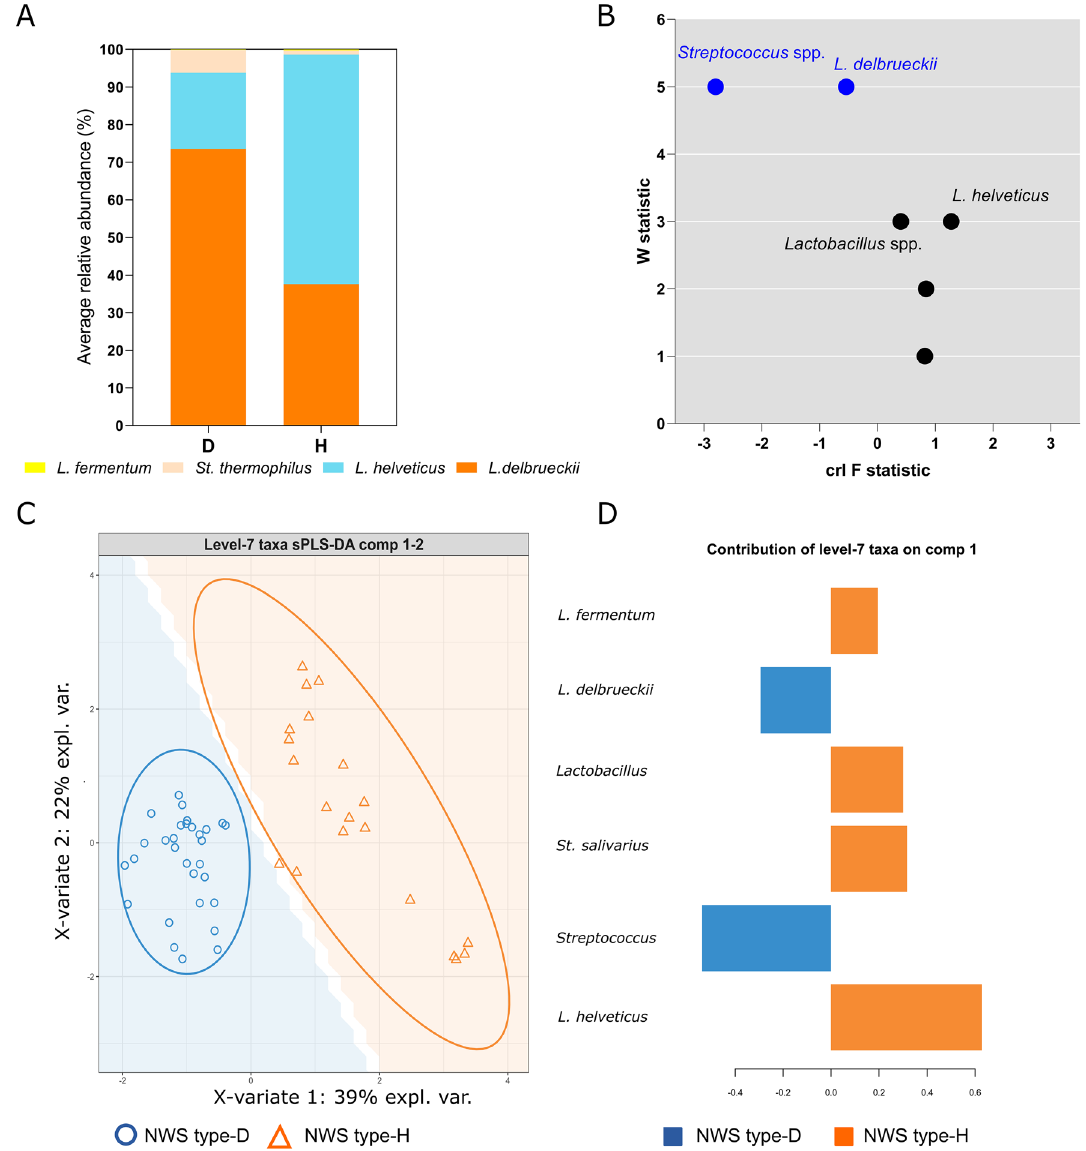
Figure 5. ( A ) Species level composition of NWS type-D and type-H. The average relative abundances of each bacterial taxon and clusters are reported on the vertical and horizontal axis, respectively. ( B ) ANCOM differential abundance volcano plot. ( C ) sPLS-DA of the NWS samples ( n = 50) showing discrimination between samples H (blue circles) and D (orange triangles). ( D ) Loading plot shows the discriminant power of species in explaining differences between groups on component PLS1. The direction of the bars (left or right) relates to the direction of the loadings in panel A. The higher the absolute value, the bigger is the discriminative power. Orange and blue bars indicate a higher abundance in D or H group, respectively. ( A ) was plotted with GraphPad Prism v.8.00 software (San Diego, CA, USA, https:// www. graph pad. com/), while ( B – D ) were built using mixOmics R package v.6.16.0 (https:// CRAN.R- proje ct. org/ packa ge= mixOm